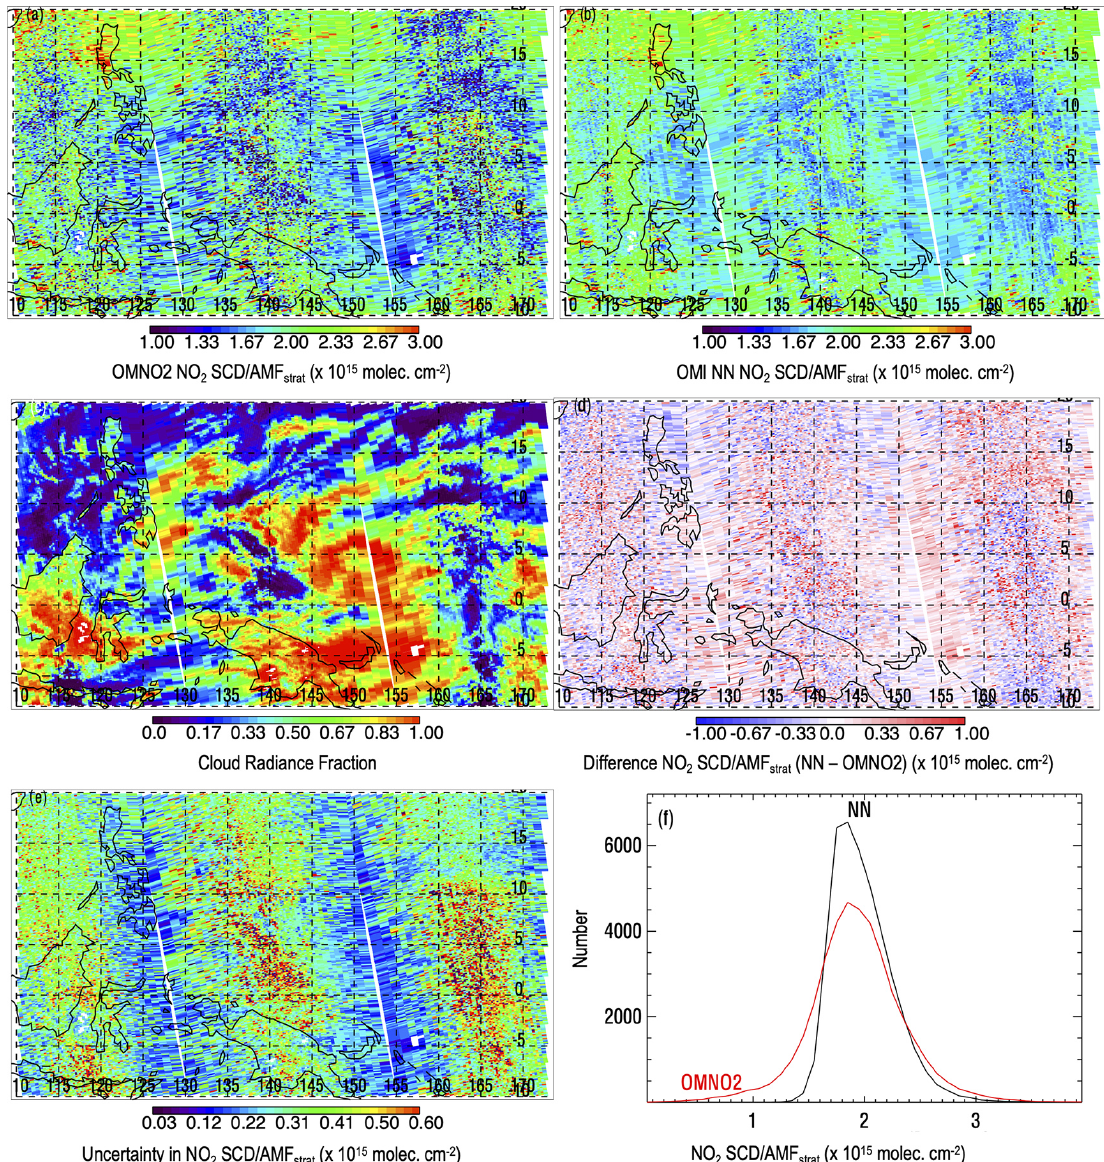
Figure 9. Normalized NO 2 SCDs from 28 January 2005 over the tropical Pacific region from (a) OMNO2 and (b) a NN applied at the OMI spectral resolution and with the OMNO2 fitting window of 402–465nm; (c) cloud radiance fraction; (d) difference between the NN and OMNO2 normalized SCDs; (e) normalized SCD fitting uncertainties from OMNO2; (f) histograms of the normalized SCDs corresponding to the area shown in panel (a)